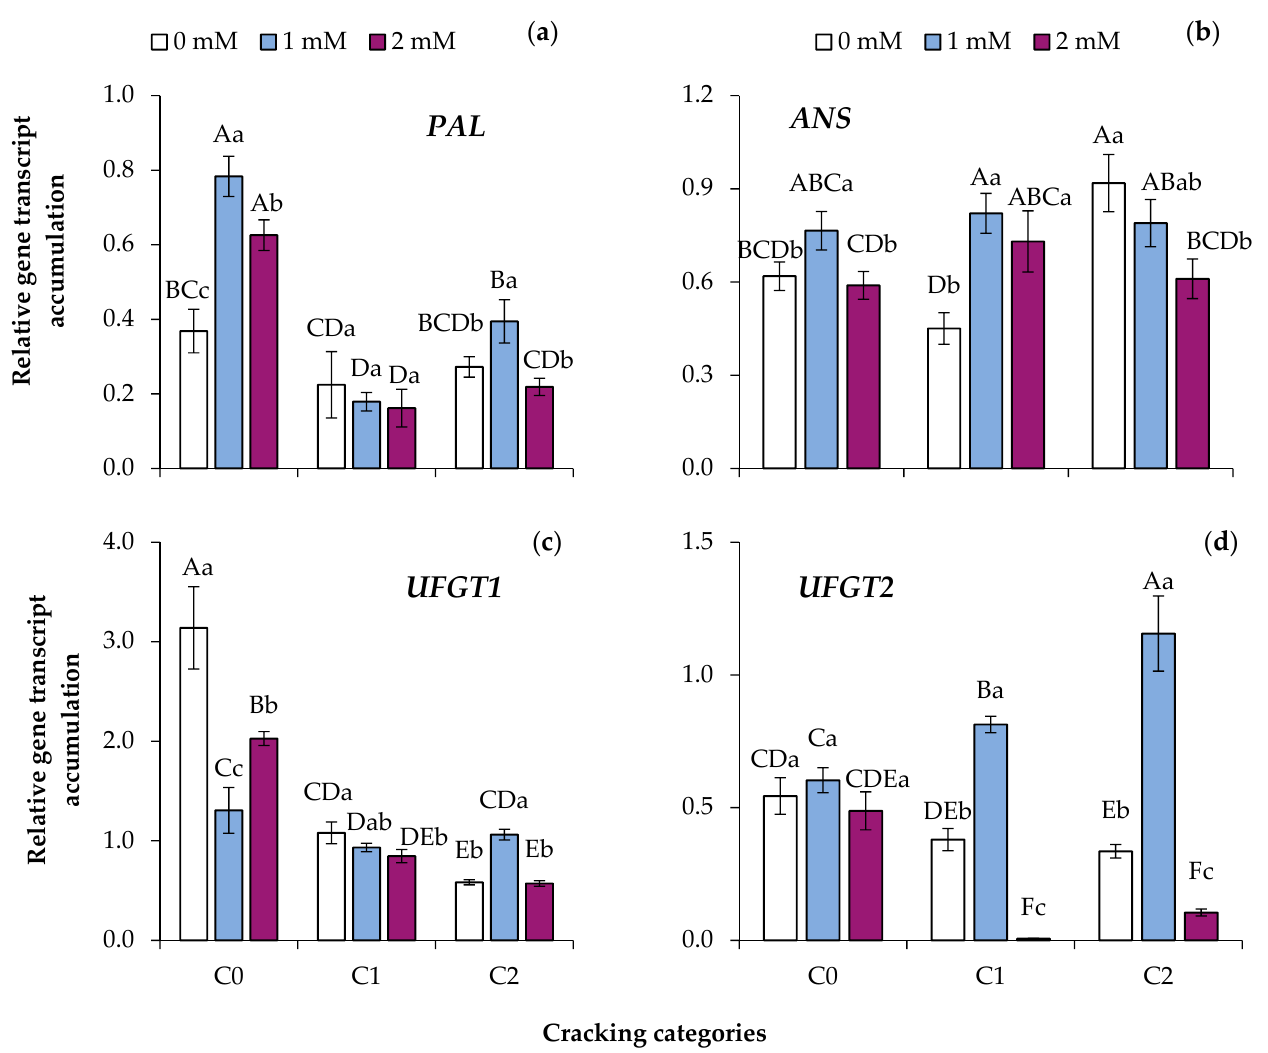
Figure 4. Changes in expression of genes coding for PAL ( a ), ANS ( b ), UFGT1 ( c ), and UFGT2 ( d ) in cracking categories of fig peel after preharvest treatment with different concentrations of salicylic acid (SA), in year 1. Categories: C0, sound fruit; C1, slightly cracked; C2, highly cracked. All data presented are means (n = 3); bars are standard deviations. Columns not sharing a common letter are significantly different by Tukey test ( α = 0.05). Lowercase letters correspond to one-way ANOVA in each cracking category; capital letters correspond to one-way ANOVA of all